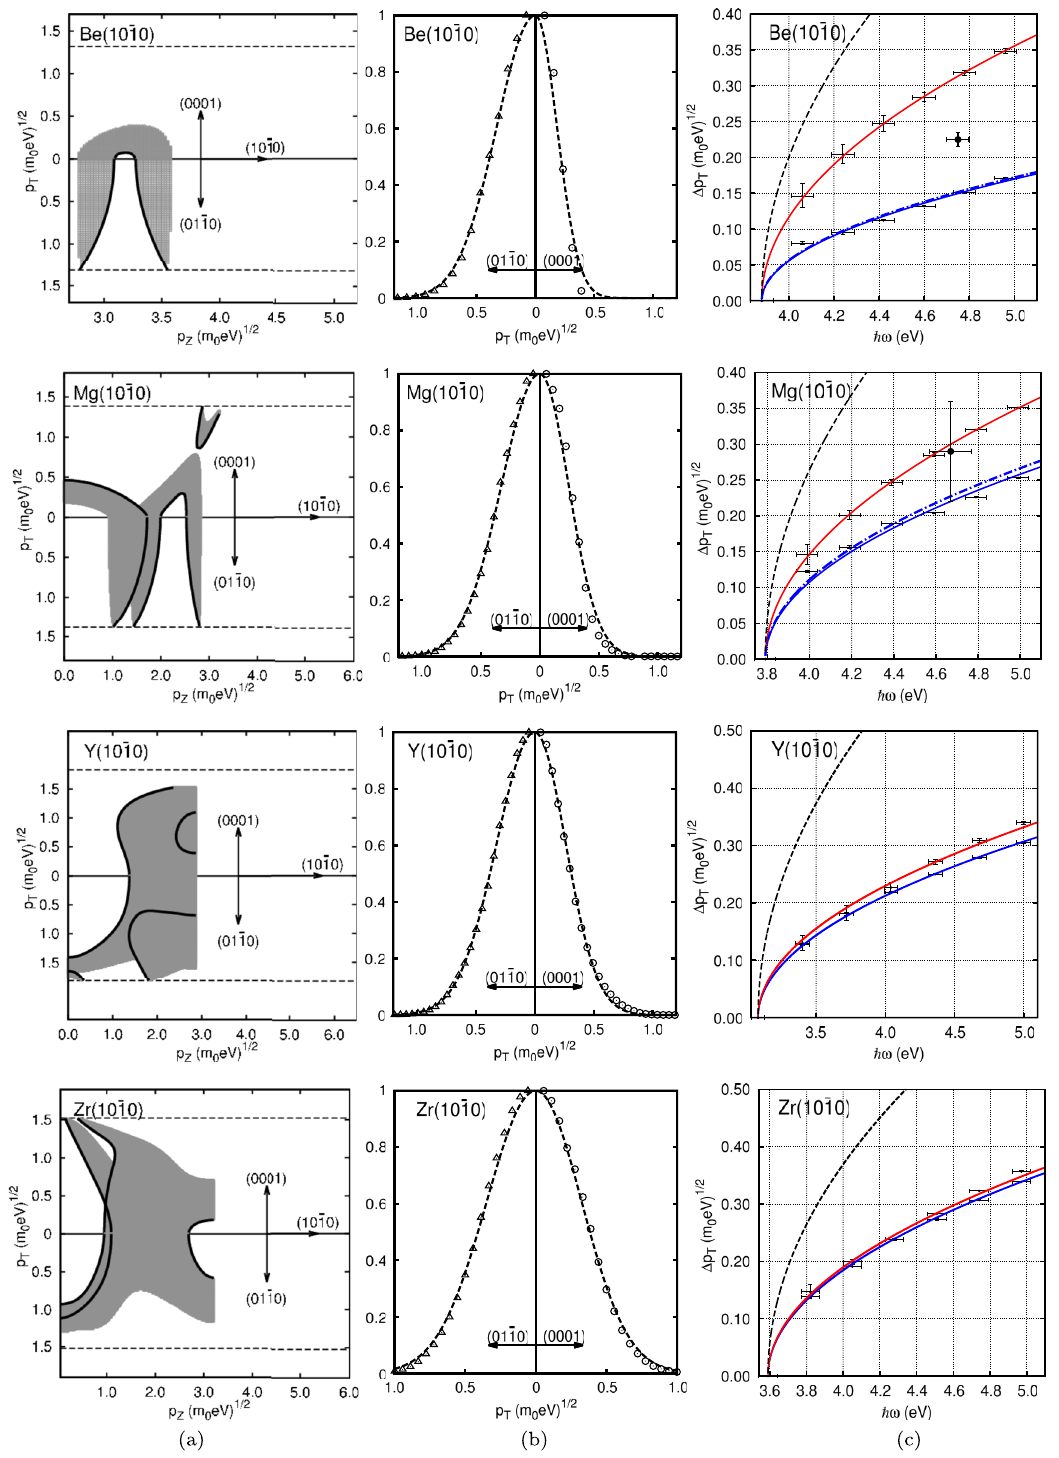
10¯10 FIG. 2. Emission properties for the ( ) face of Be, Mg, Y and Zr metals. Column (a): Crystal momentum map of the electronic ffiffiffiffiffiffiffiffiffiffiffiffiffiffiffi p ¼ 2 m Δ E states (shaded regions) below the Fermi level (solid line) that may photoemit within p (dashed lines) for the transverse 0 T; max ¯ 10 (0001) and ( 01 ) crystal directions. Column (b): Transverse momentum distributions of the photoemitted electrons in the (0001) and 01¯10 ( ) directions (Gaussian fits are guides to the eye). Column (c): Incident photon energy dependence of the rms transverse momentum Δ p → 0 (data points with solid red line fit, for ( 01¯10 ) crystal direction and solid blue line fit for (0001) for electron temperatures T T e ð ℏ ω Þ from Refs. [14] and [15] (dashed line). Black circles show the measured crystal direction), together with the expected form of Δ p T Δ p data from Refs. [34] and [36] for Be and Mg, respectively. T